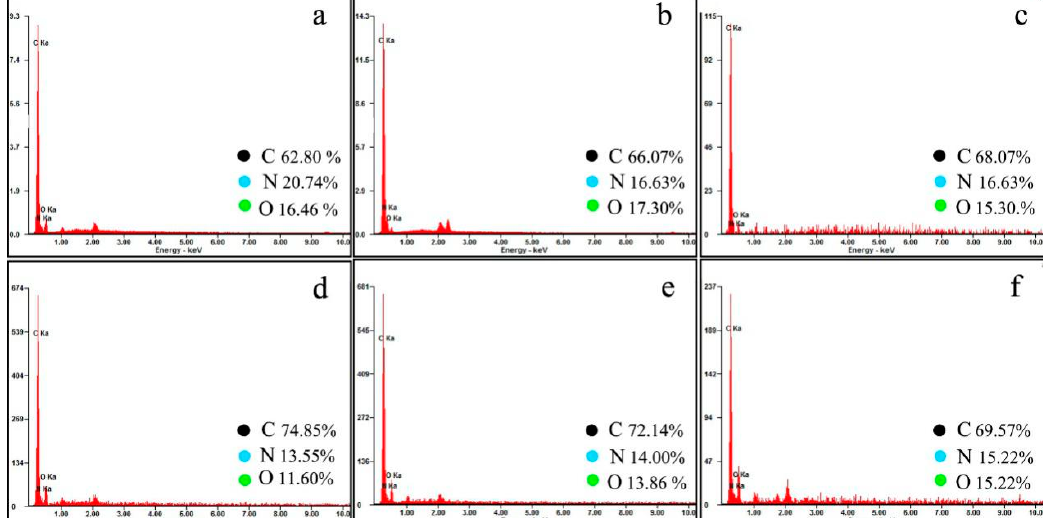
Figure 10. TEM morphologies of microcapsule samples, ( a , b ) pure graphene, ( c ) M-0, ( d ) M-4, ( e ) M- 5, and ( f , g ) shell materials of M-5. Figure 10 shows the TEM morphologies of graphene on the microcapsule shells. Pure graphene has a single layer structure with size of 100 nm (Figure 10a,b). Microcapsules (M-0) have smooth HMMM shells with compactable global shape (Figure 10c). Comparatively, graphene is found on the shell surface of shells of M-4 and M-5 microcapsule samples as the arrows shown in Figure 10d,e. It can be seen that M-5 possesses more graphene on its surface than M-4. This phenomenon is consistent with the results of EDS. A few microcapsules (M-5) were destroyed and washed with alcohol to